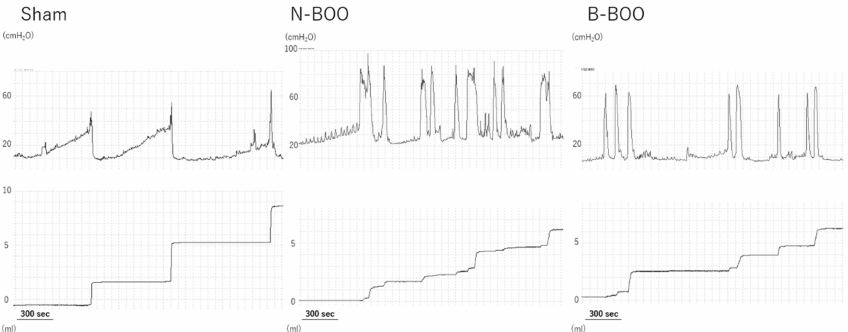
Figure 1. Representative cystometrogram recordings for the Sham, N-BOO and B-BOO